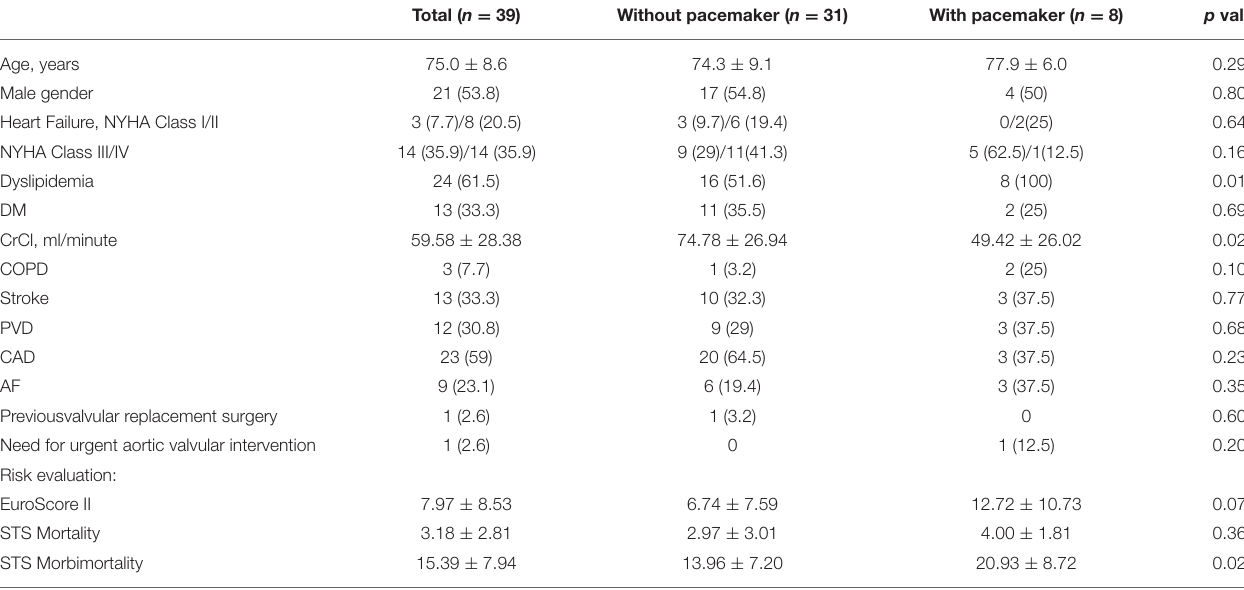
TABLE 1 | Baseline characteristics according to the group of study population: Total, without permanent pacemaker (PPM) and with